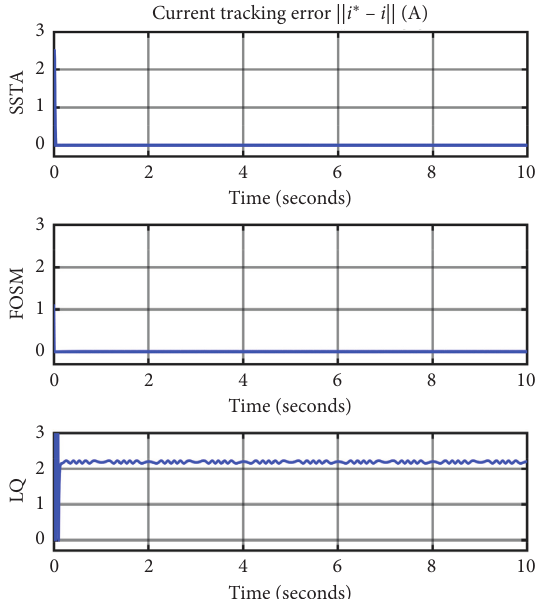
Figure 12: Current error